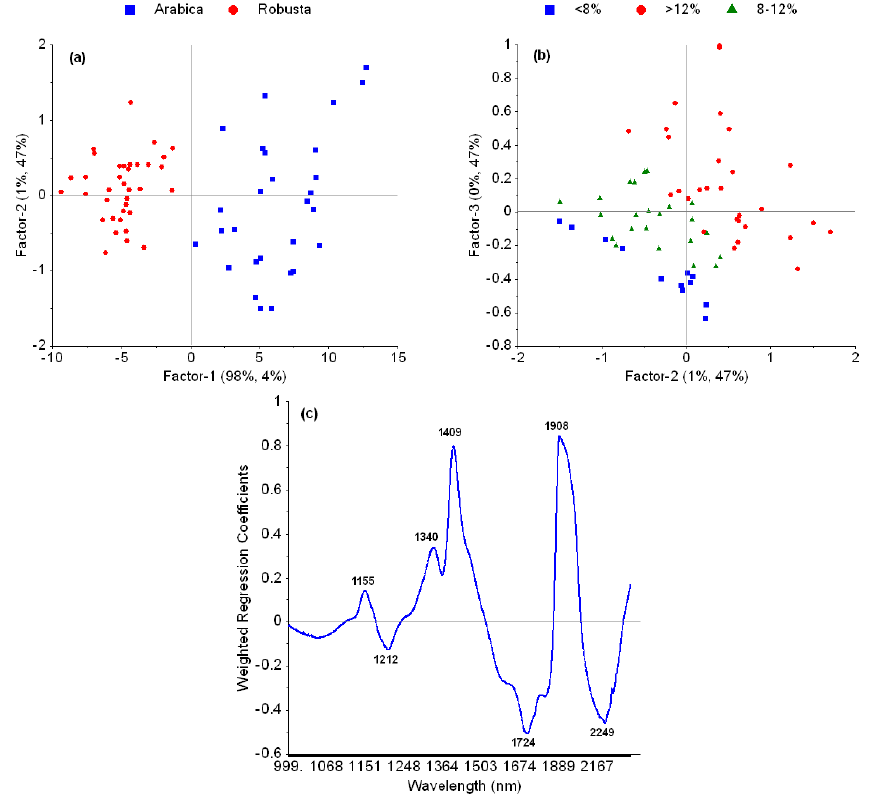
Figure 3. Score plots of PLSR for moisture content prediction based on raw diffuse reflectance (log 1/R) near infrared spectra. A distinct clustering of Arabica and Robusta coffee samples is observed when displaying PC 1 vs. PC2 (herein: factor-1 and factor-2) ( a ); Sample allocation is following moisture content indicating the importance of PC 2 and 3 for moisture prediction ( b ); Weighted regression coefficients obtained from PLSR using raw spectra ( c